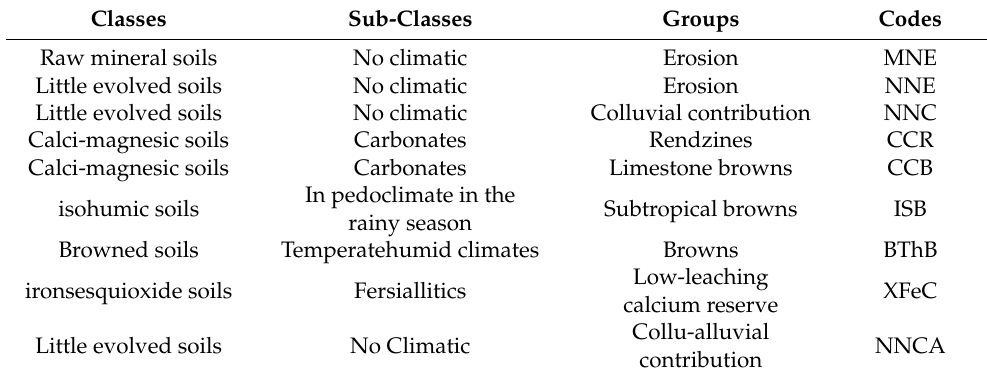
Table 1. Description of the soil unit codes. Classes